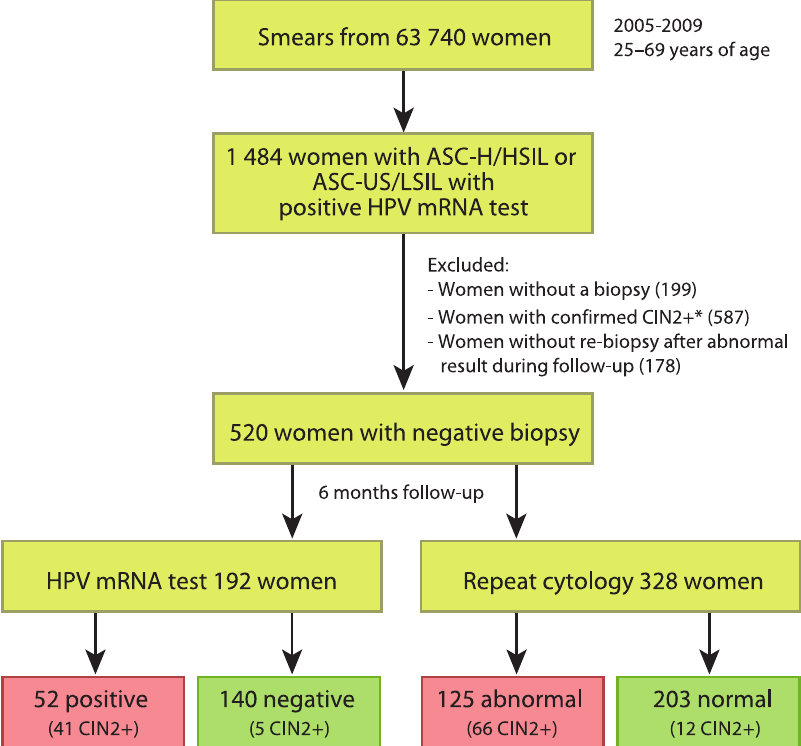
Figure 1. Flow chart showing the two study populations.